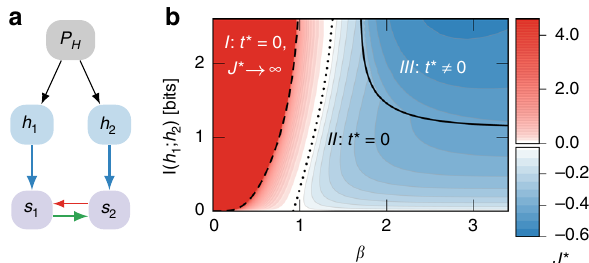
Fig. 2 Optimal sensing for correlated signals. Nonequilibrium sensing is optimal in the low-noise, high-correlation limit for correlated Gaussian signals. a We assume that the signal directly in fl uences both sensors with varying correlation, Eq. (10). b The optimal coupling J * as a function of sensor reliability β and the signal redundancy, i.e., the mutual information between the input signals I ( h 1 ; h 2 ). The optimal coupling diverges J * → ∞ at small β (region I, left of the dashed curve) and decreases with larger β . Between the dashed and solid curves (region II), the mutual information I ( S ; H ) is maximised by equilibrium sensors with a fi nite J * that changes from cooperative (red) to anticooperative (blue) at the dotted line. Nonequilibrium sensing is the optimal strategy for signals with relatively high redundancy in the low-noise limit (region III, above the solid